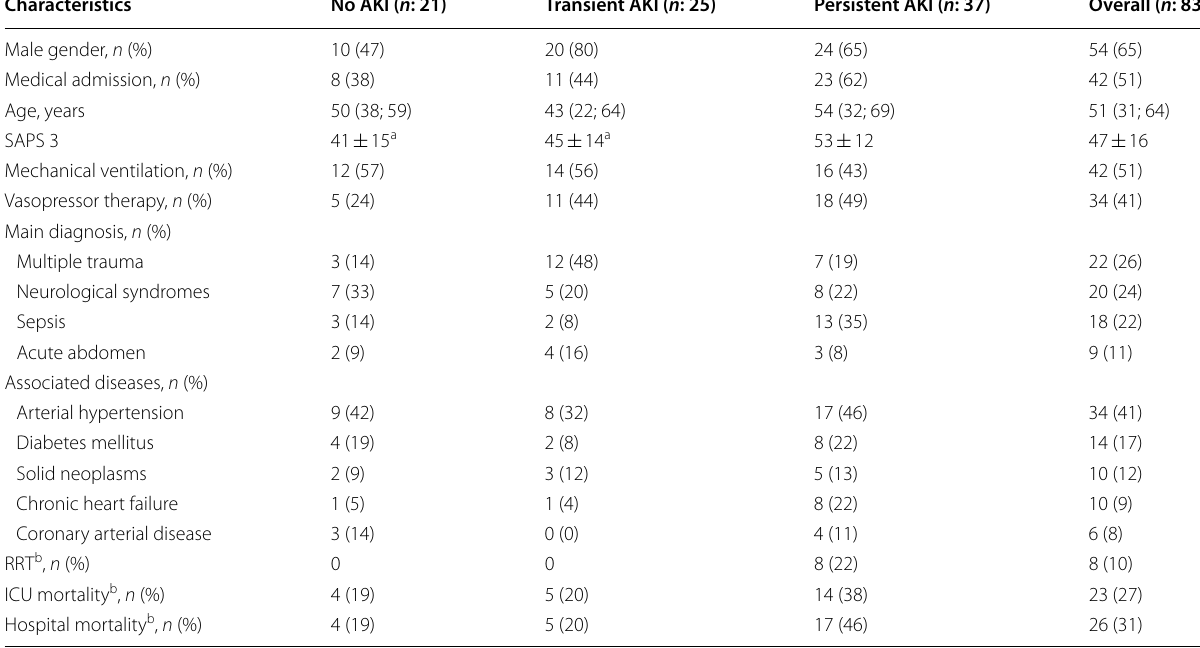
RRT renal replacement therapy, ICU intensive care unit, AKI acute kidney injury a p < 0.05 compared to persistent AKI